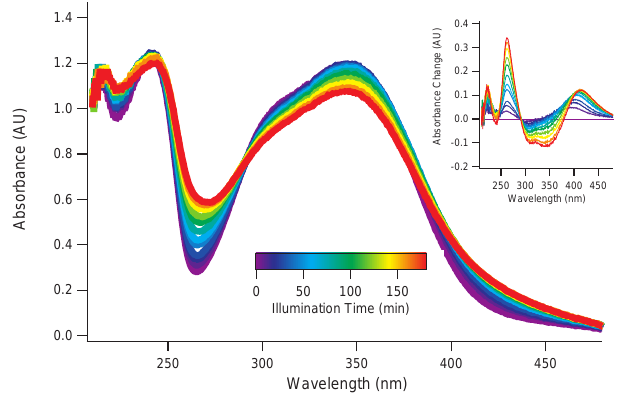
Figure 6. Spectral change of a 4NC solution (4µM) during a di- rect photolysis experiment. The inset shows the absorbance change compared to the initial condition.